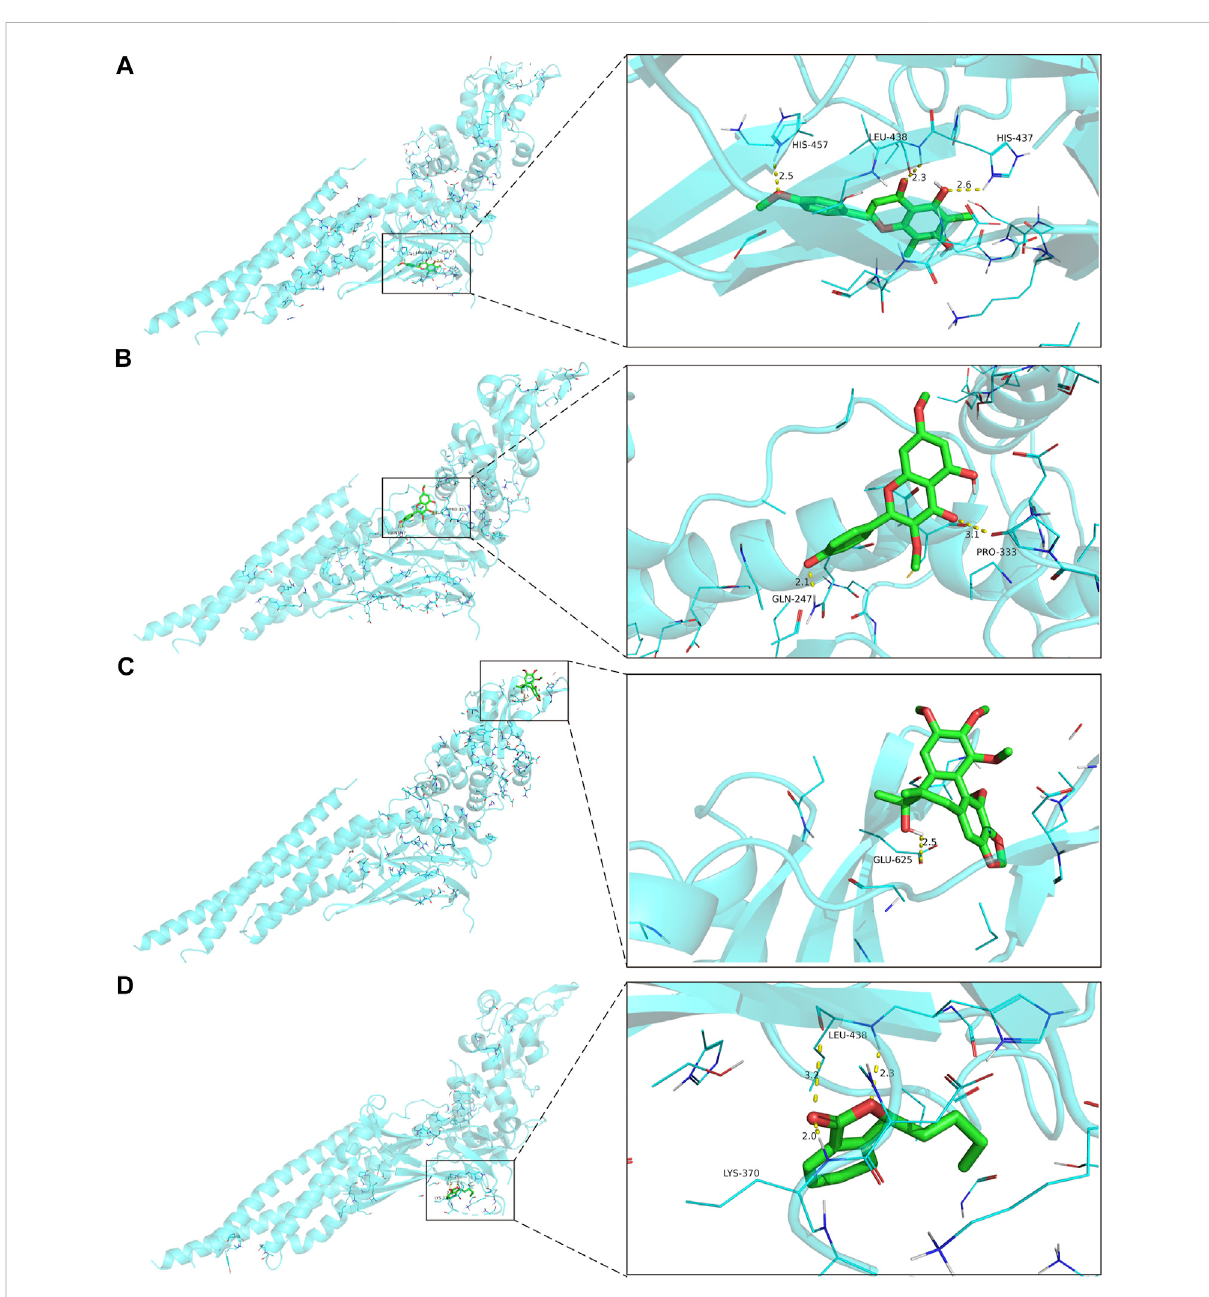
FIGURE 5 The binding site of the main active components of FZYX and STAT3. (A) Gomisin A and STAT3. (B) Kumatakenin and STAT3. (C) Methylophiopogonanone B and STAT3. (D) Senkyunolide A and STAT3. The dashed line in the fi gure is the hydrogen bond and the value is the bond